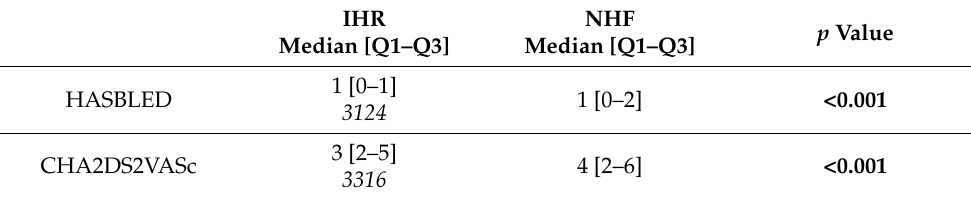
Table 2. Comparison of HASBLED and CHA2DS2VASc scores in IHR and NHF data.